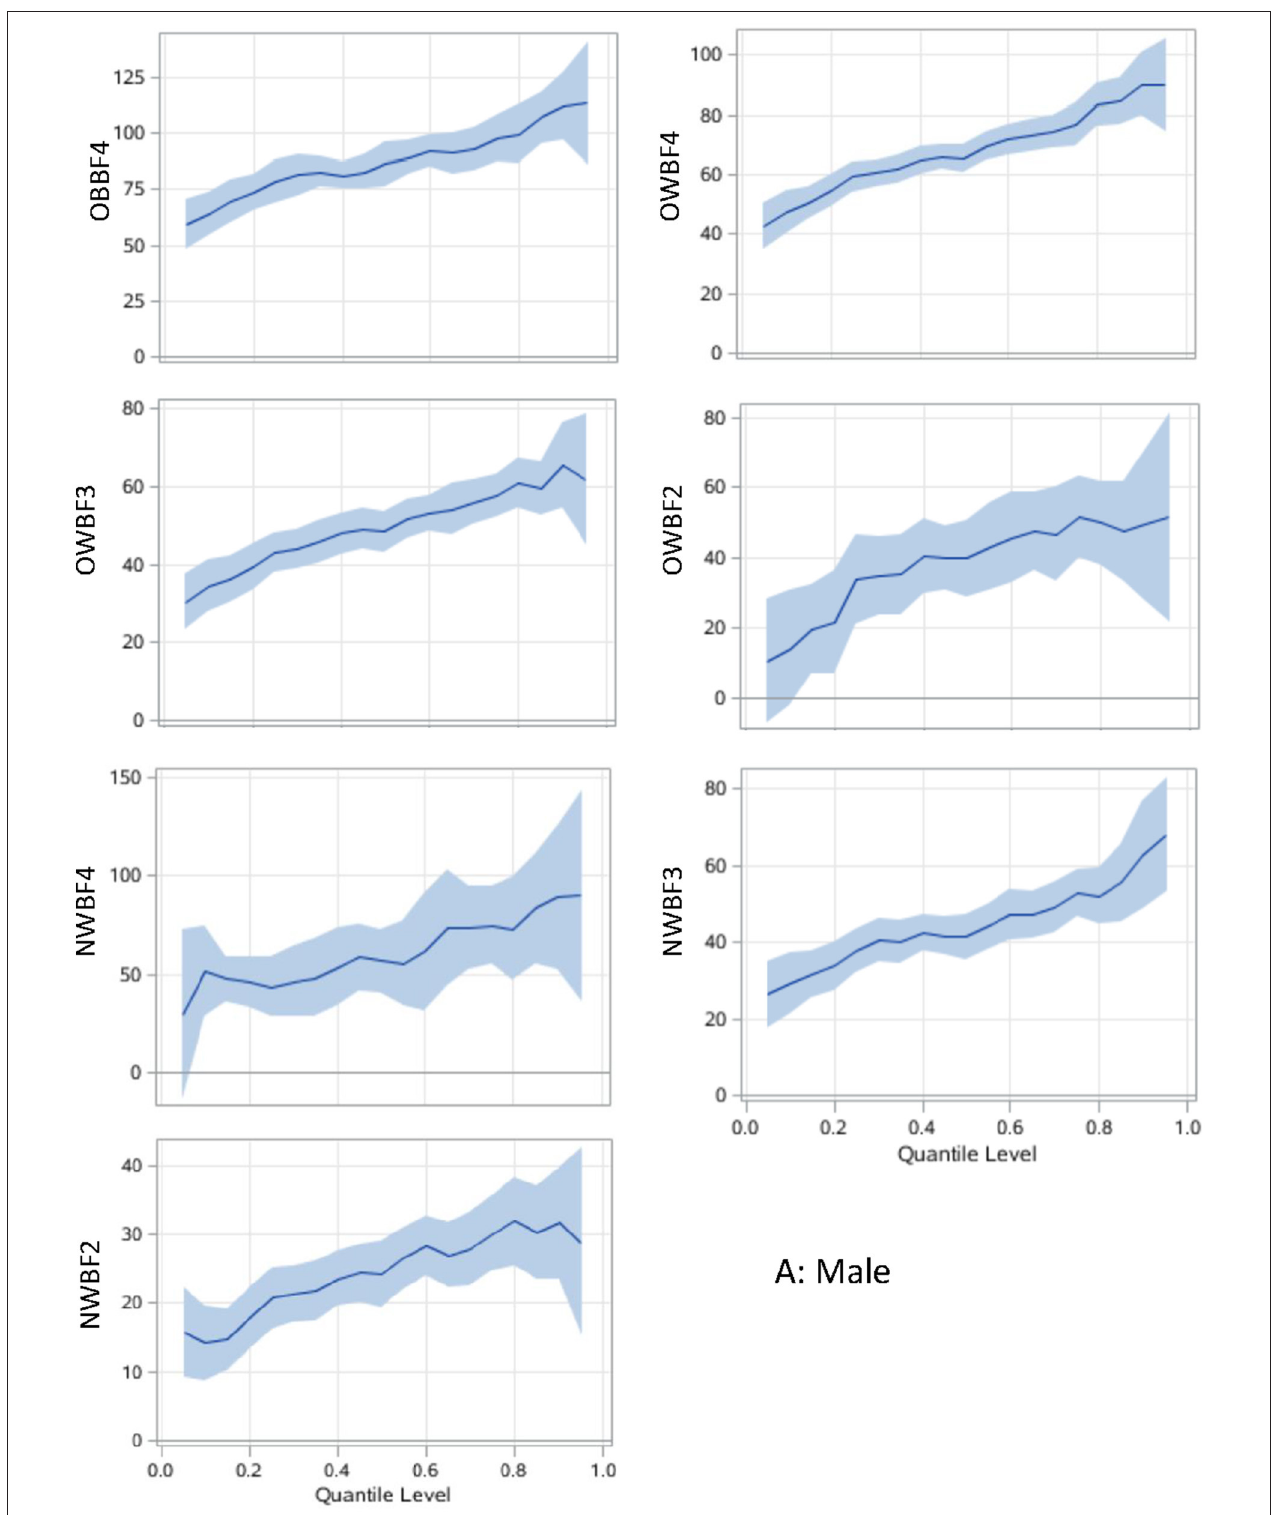
FIGURE 1 | Associations between body adiposity and SUA among men using quantile regression models. The under or normal weight group with the lowest %BF quartile is the reference group. The models are adjusted for age, study sites, residential areas, educational attainment, and alcohol consumption. The x-axis is the quantile level of SUA, and the y-axis is the difference of SUA level between the current group and the reference group. The solid lines represent the estimated effect